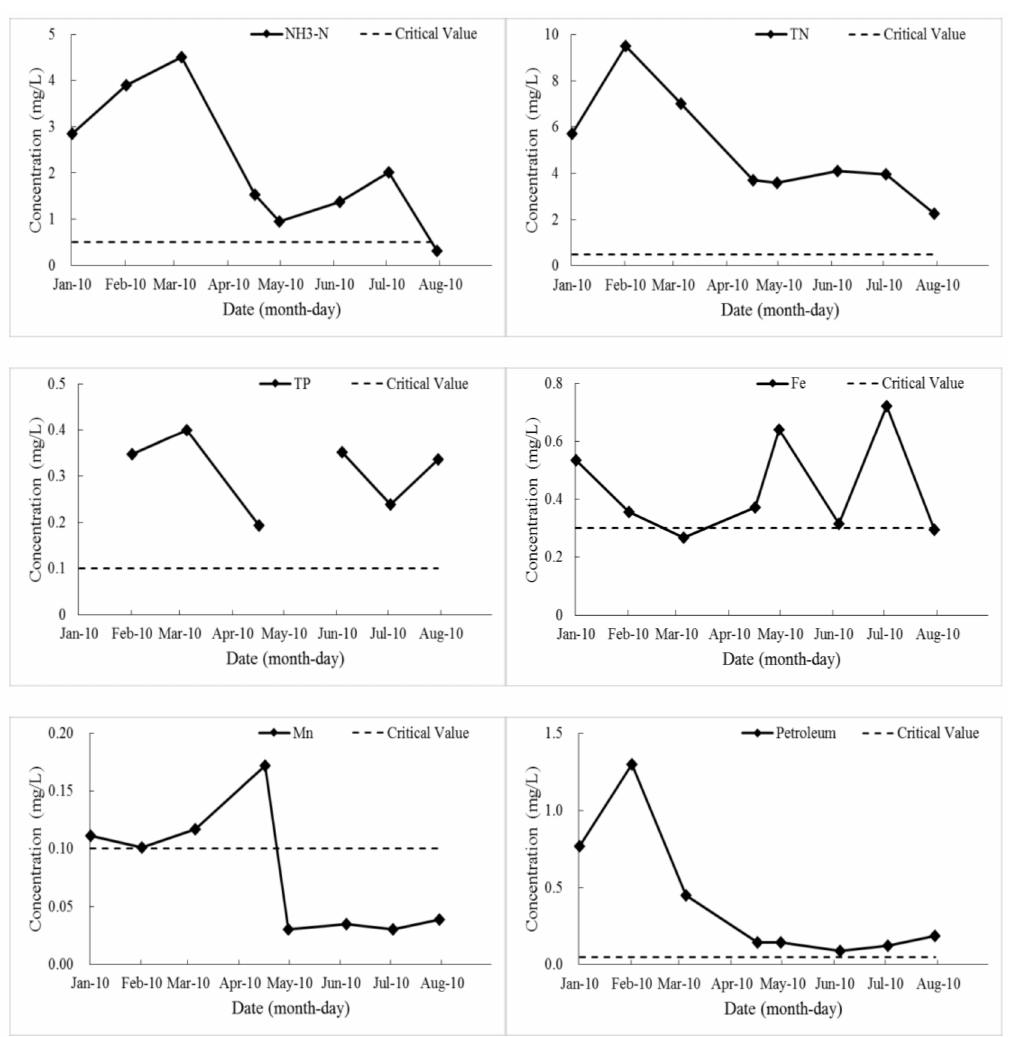
Figure 10. Water quality indices (COD, BOD, NH3-NTN, TP, Fe, Mn, and Petroleum) in Xijiu Lake during 2011, showing poor water quality that does not meet the standards for drinking water